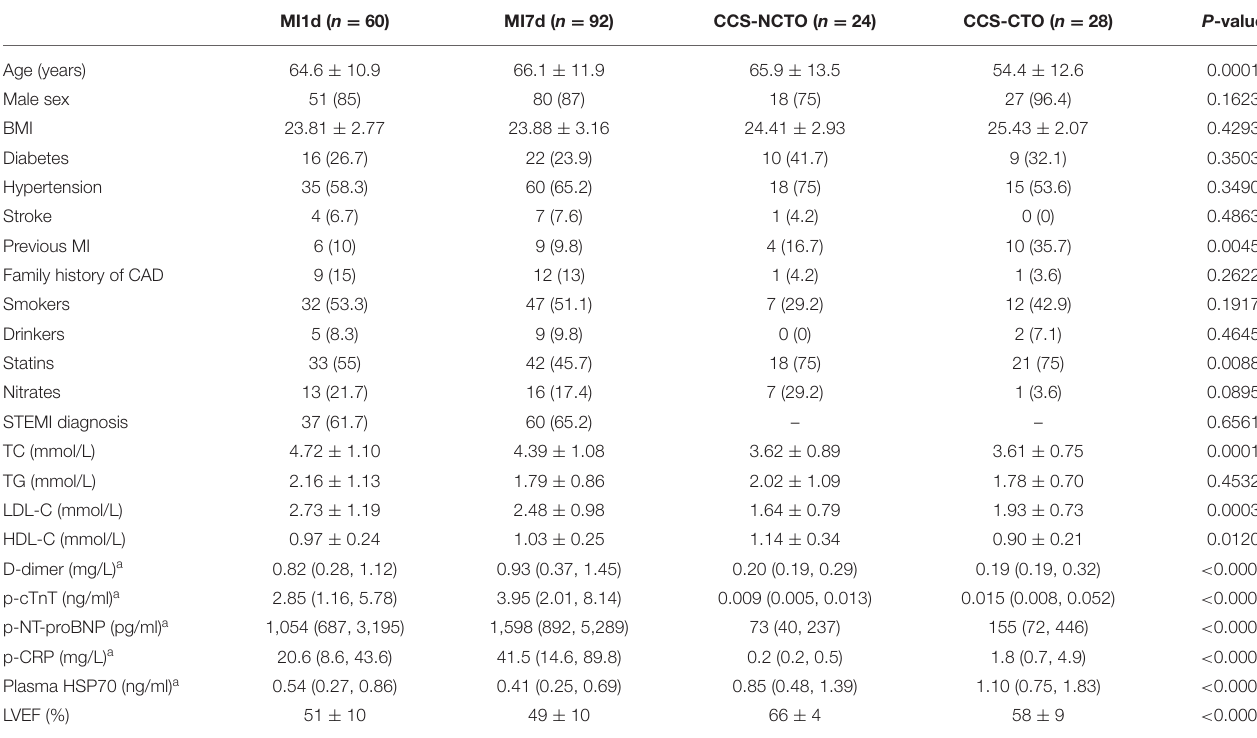
TABLE 2 | Population characteristics of the four subgroups.